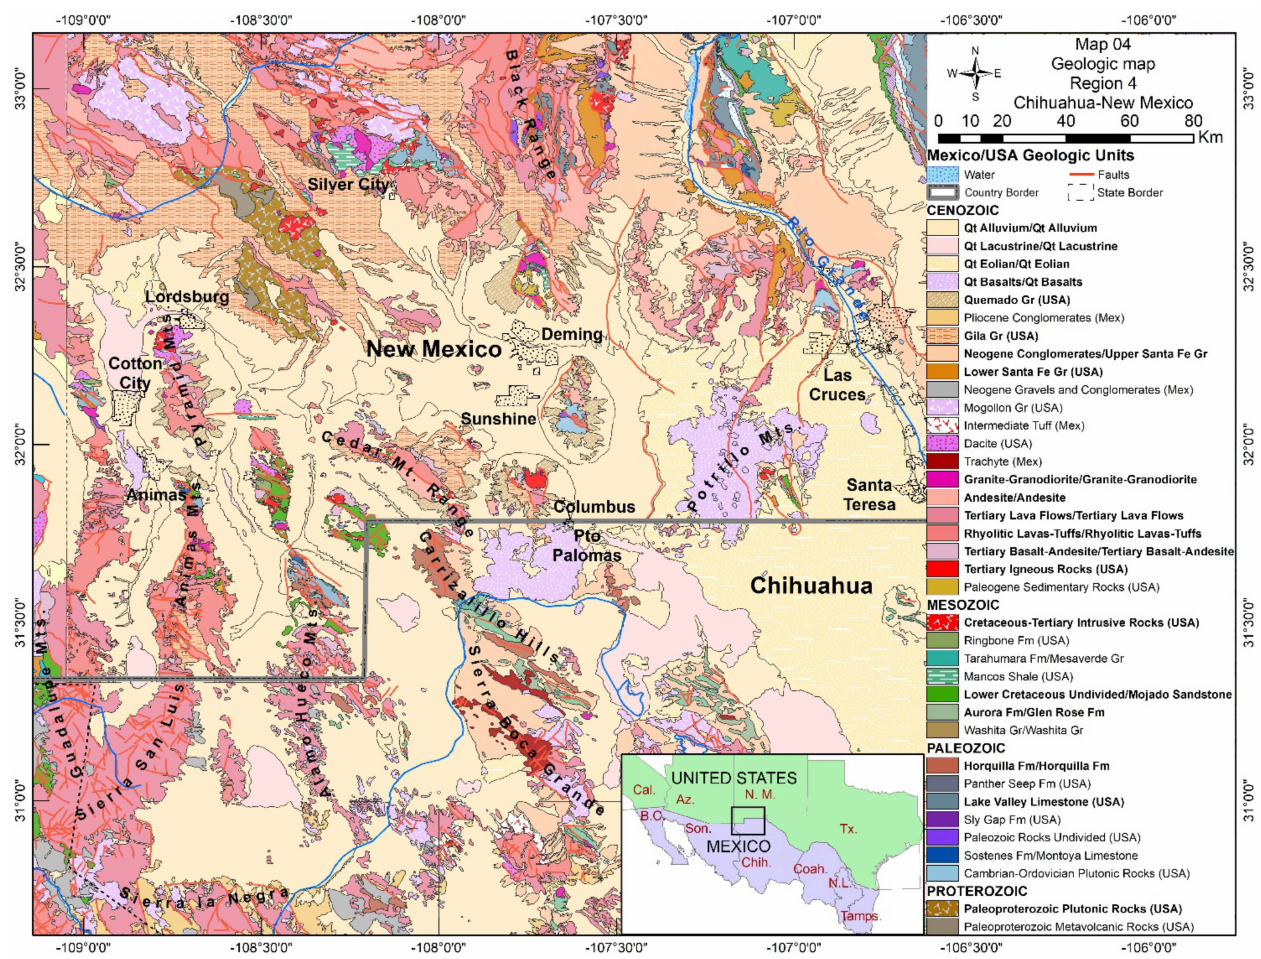
Figure 4. Geologic map, Chihuahua—New